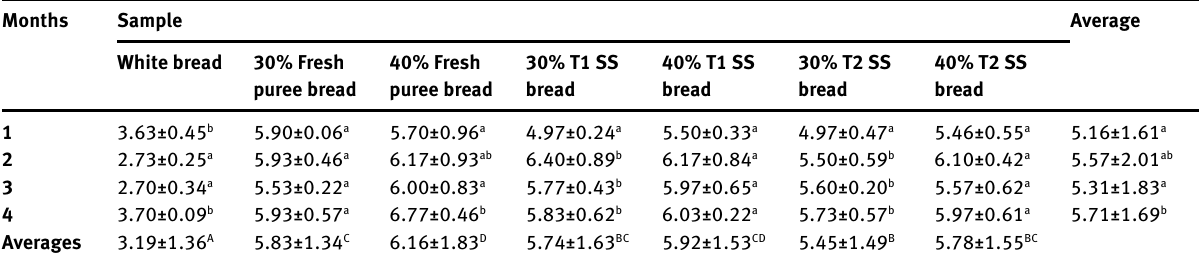
Table 3: Sensory Scores for Crust Color Months